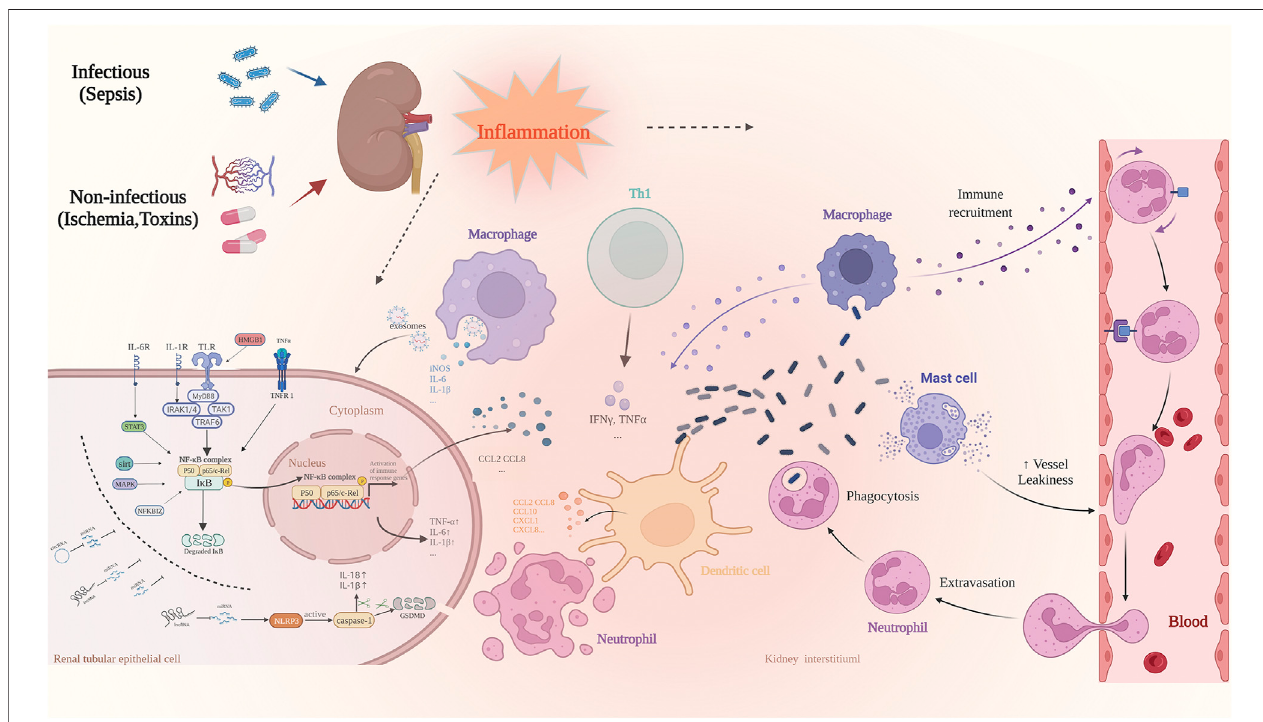
FIGURE 1 | The most common causes of AKI include sepsis, ischemia-reperfusion, and nephrotoxic drug injury. It is involved in a variety of pathophysiological processes, of which in fl ammatory response is one of the most important pathological features. When AKI occurs, the damaged renal tubular epithelial cells increase the permeability of vascular endothelial cells by releasing pro-in fl ammatory cytokines, whereas activated renal tubular epithelial cells and dendritic cells secrete chemokines such as CCL10 and CXCL1, followed by a large number of immune effector cells into circulation. These include neutrophils, monocytes, and T cells, which are recruitedto the site ofinjury. The resident and recruited immune cells simultaneously secrete pro-in fl ammatorymediators such as TNF- α , IFN- γ , IL-6, and IL-1 β ,and the induced in fl ammatory cascade further aggravates the damage of renal tubular epithelial cells.Many signal transduction pathways are involved in the regulation of in fl ammation-related genes at the transcription level. The most important is the NF- κ B pathway. NcRNAs play an important role in regulating the in fl ammatory response of AKI, and regulate the acute in fl ammatory response in the kidneys via a variety of targets as enhancers or inhibitors.